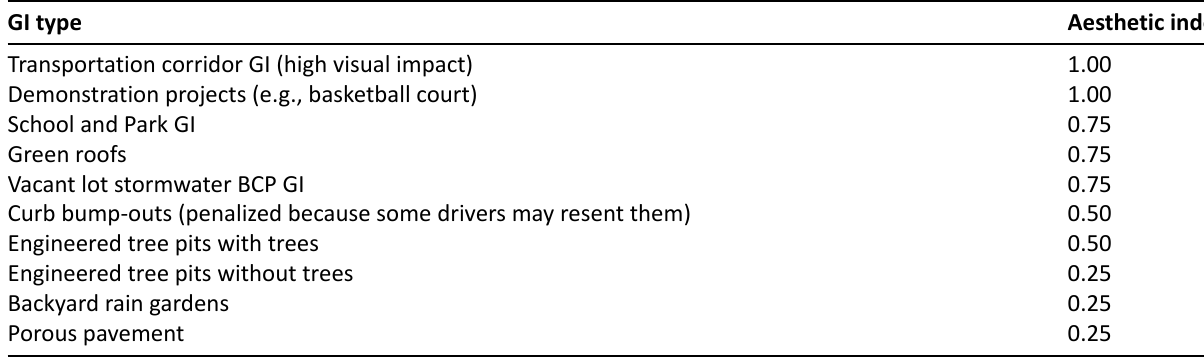
Table 3. Aesthetic indices assigned to Point Breeze GI types. GI